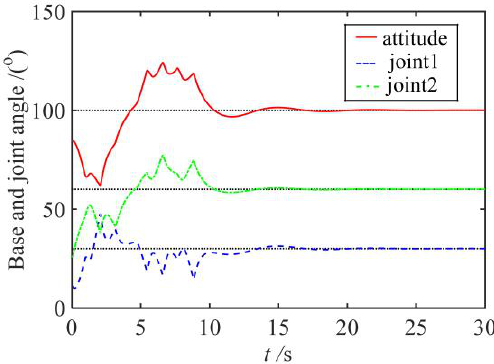
C2 C2 F =80 N m, F =10 N m   ). Figure 14. Base and joint angle (F = 80 N · m, F C2 O2 C2